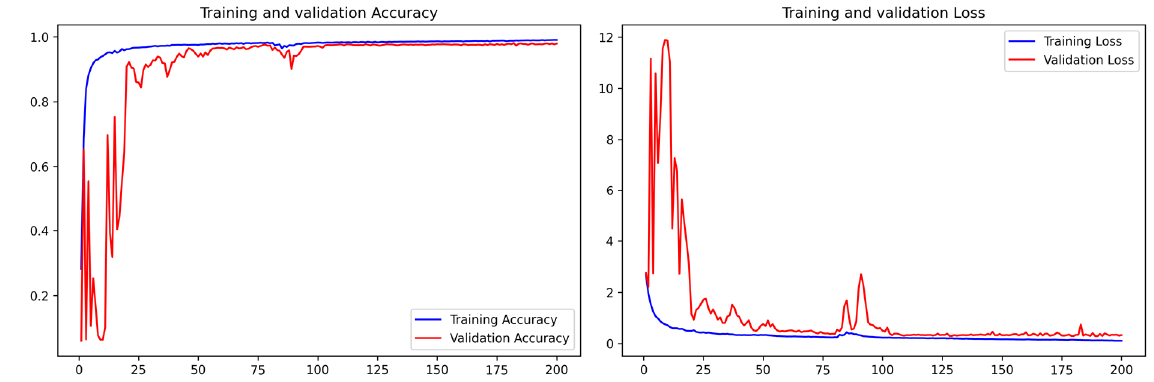
Figure 4 . The accuracy and loss during training U-Net++